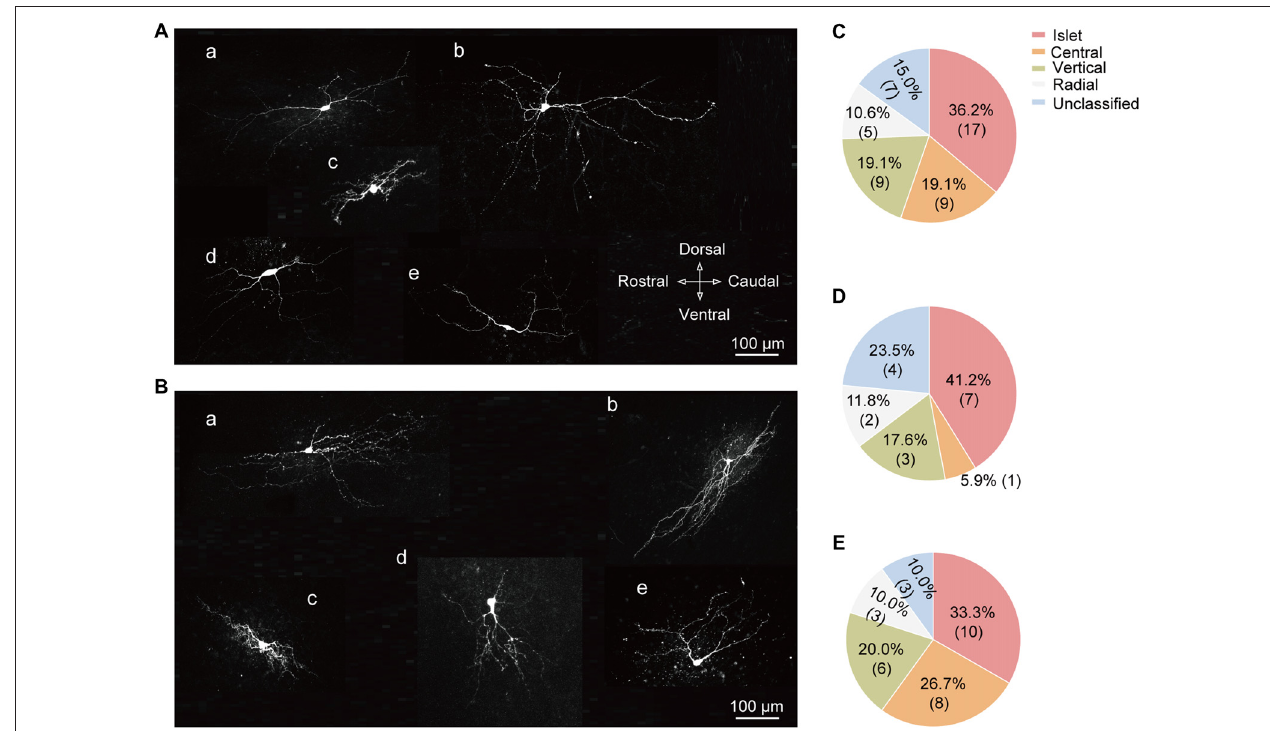
FIGURE 6 | Cell-type specific expression of T-type currents in SG neurons. (A) Exemplar confocal images showing the neurobiotin 488-filled T-type current-expressing neurons. They were classified as: islet cell (a) ; radial cell (b) ; central cell (c) ; vertical cell (d) ; and unclassified cell (e) . Scale bar = 100 µ m. (B) Exemplar confocal images showing the neurobiotin 488-filled T-type current-lacking SG neurons assigned to the same order in (A) . (C) Prevalence of five different morphological subtypes in SG neurons. (D,E) Summary data showing the percentage of different morphological subtypes in T-type current-expressing (D) and -lacking neurons (E)